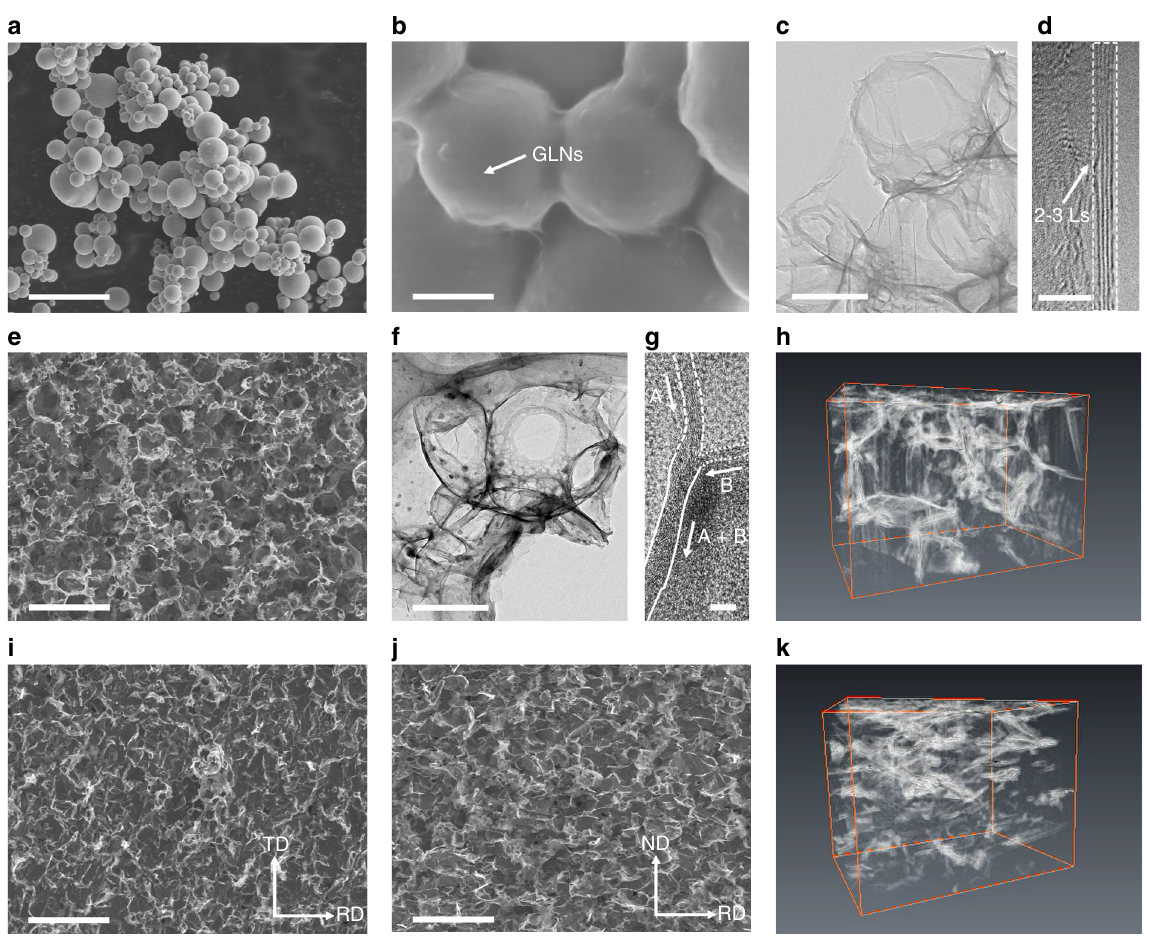
Fig. 2 Characterizations of composite powders and bulk materials. a , b SEM image of the as-grown GLNs/Cu composite powders with a loosely-packed- sphere structure ( a ) and the typical morphology of uniform GLNs coating structure around Cu powders ( b ) synthesized at 800 °C. Scale bar, 5 μ m ( a ); 200 nm ( b ). c , d TEM image of GLNs after etching Cu powders ( c ) and the corresponding high-resolution TEM (HRTEM) image of the edge area ( d ), in which the thickness of GLNs was determined as 2 – 3 layers. Scale bar, 200 nm ( c ); 2 nm ( d ). e , f SEM image ( e ) and TEM ( f ) image of 3D-GLNN after Cu etching in the hot-pressed 3D-GLNN/Cu composites. Scale bar, 5 μ m ( e ); 200 nm ( f ). g HRTEM image of the Y-type interconnection area of 3D-GLNN, where the layer A and layer B merged into layer A + B. Scale bar, 5 nm. h , k Snapshot of FIB-3D reconstruction results of 3D-GLNN in the h